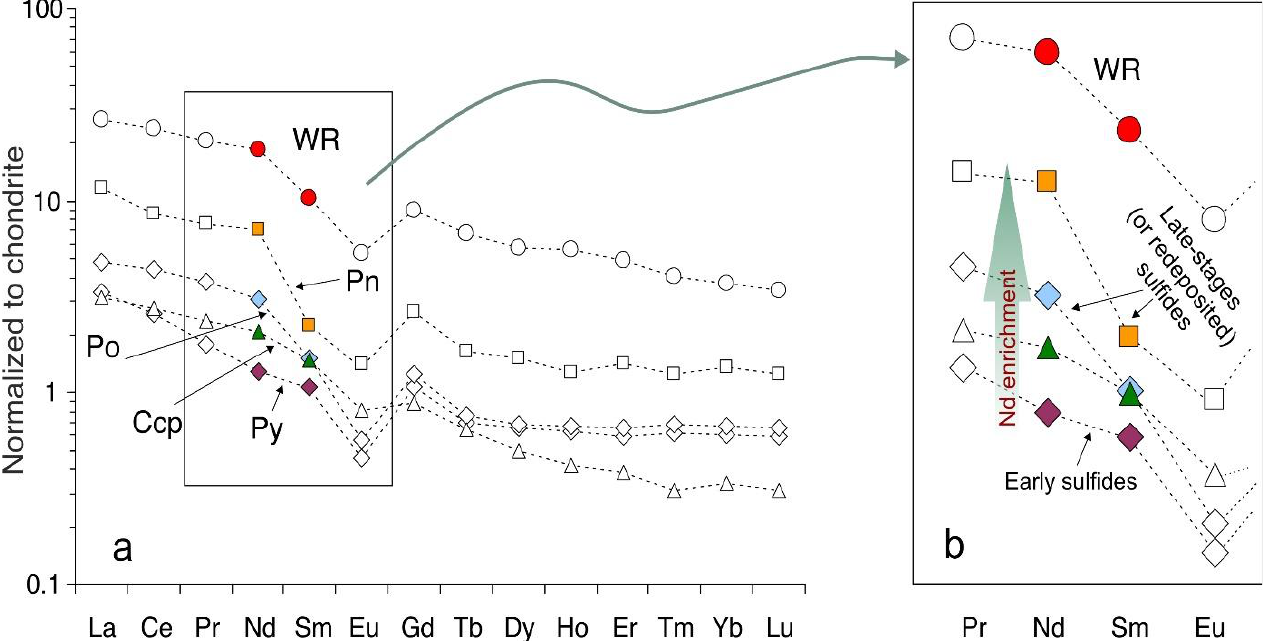
Figure 7. The effect of the Nd enrichment of sulfides from the magmatic mafic – ultramafic complexes ( a ) and that of the sulfides from different stages of the formation of minerals from the hydrothermal deposits ( b ). Sulfides from the magmatic Cu-Ni-PGE complexes feature a predominant (selective) accumulation of Nd in the sequence of pyrite – chalcopyrite – pyrrhotine – pentlandite, which corresponds to the most probable script of ore formation in intrusive complexes. The sulfides from hydrothermal deposits feature a more significant Nd enrichment effect that is closely associated with ore-forming fluids, which cause the formation of sulfide mineralization in several stages.